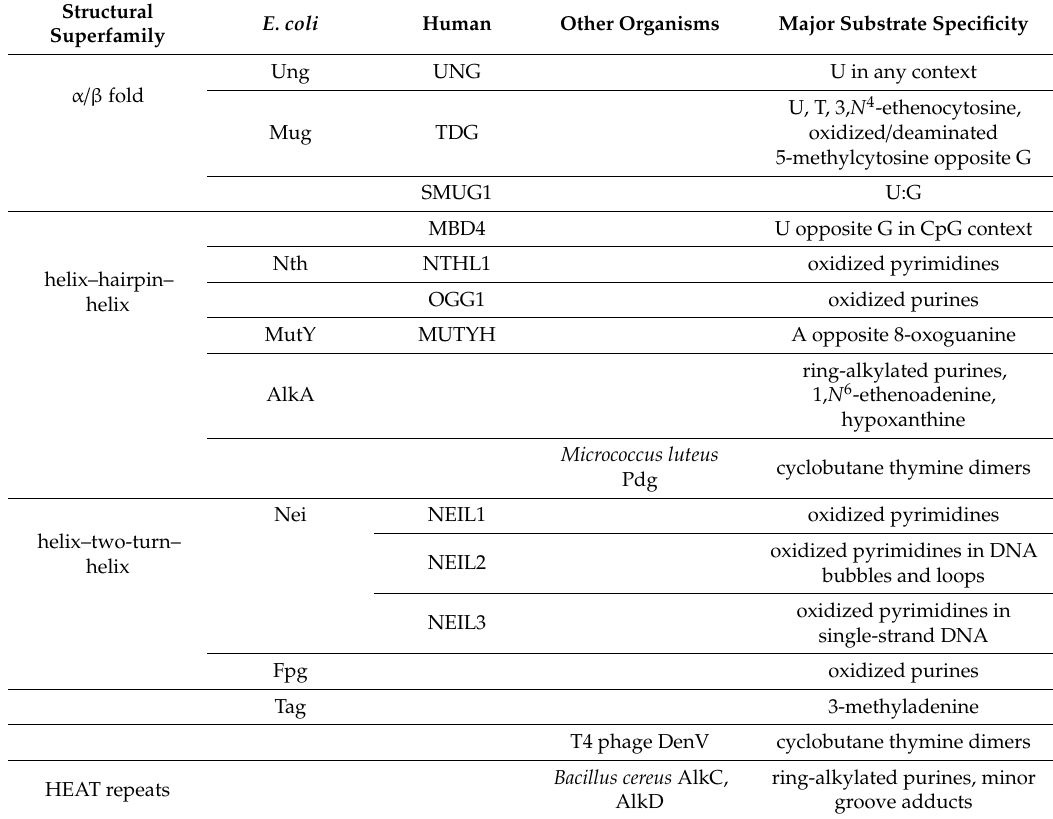
Figure 1. General base excision repair (BER) scheme. Bases are represented by shaded squares, and sugars by white squares. A damaged base (black) is excised by a DNA glycosylase (1); the resulting apurinic / apyrimidinic (AP) site is cut by an AP endonuclease (2); the deoxyribose fragment is removed by a deoxyribophosphate lyase (3); a correct dNMP is incorporated by a DNA polymerase, and the nick is sealed by a DNA ligase (4). Nicked DNA also activates signaling by poly(ADP-ribose)polymerase 1 (PARP1), which initiates poly(ADP-ribosyl)ation of many chromatin proteins to facilitate the access of DNA repair factors to the site of damage. Table 1. Examples of DNA glycosylases found in humans, Escherichia coli , and other